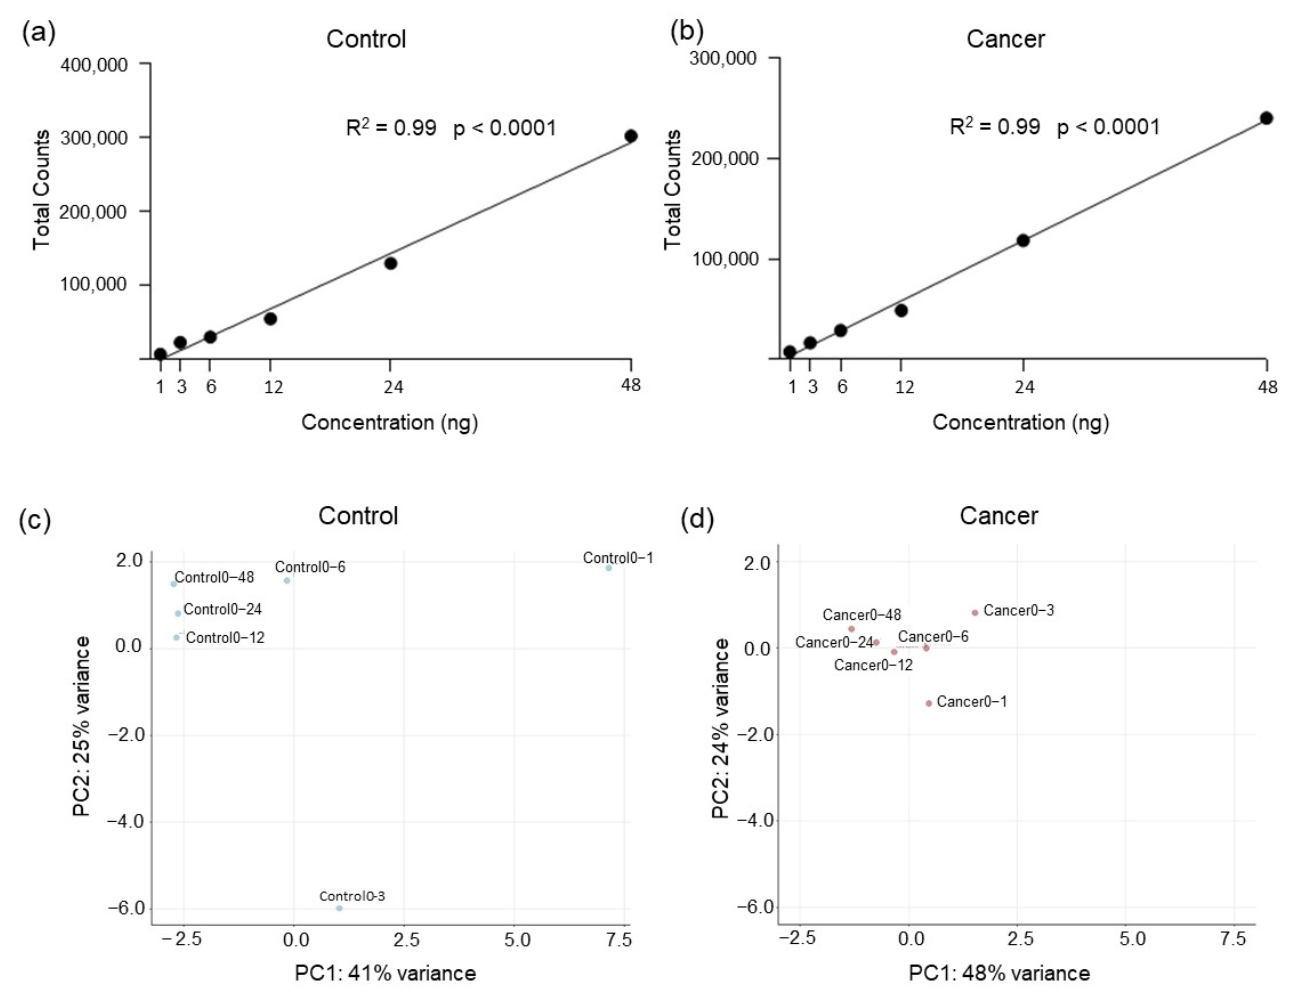
Figure 1. Titration experiment using total RNA derived from blood platelets of cancer patient and asymptomatic individual. ( a ) Six different inputs (1 ng, 3 ng, 6 ng, 12 ng, 24 ng and 48 ng) of total RNA derived from platelets of a non-cancer individual (Control) were tested using human immunology v2 panel with nCounter platform. Total number of counts detected (after negative background removal) follow a linear regression model (R 2 = 0.99, p -value < 0.0001). ( b ) A similar experiment was performed using total RNA derived from lung cancer platelet sample, and in this case, the total number of counts after background removal follow a linear regression model (R 2 = 0.99, p -value < 0.0001). ( c ) Principal Component Analysis (PCA) assessing RNA profile of Control sample using six different initial inputs of total RNA. ( d ) PCA assessing RNA profile of Cancer sample using six different initial inputs of total RNA.